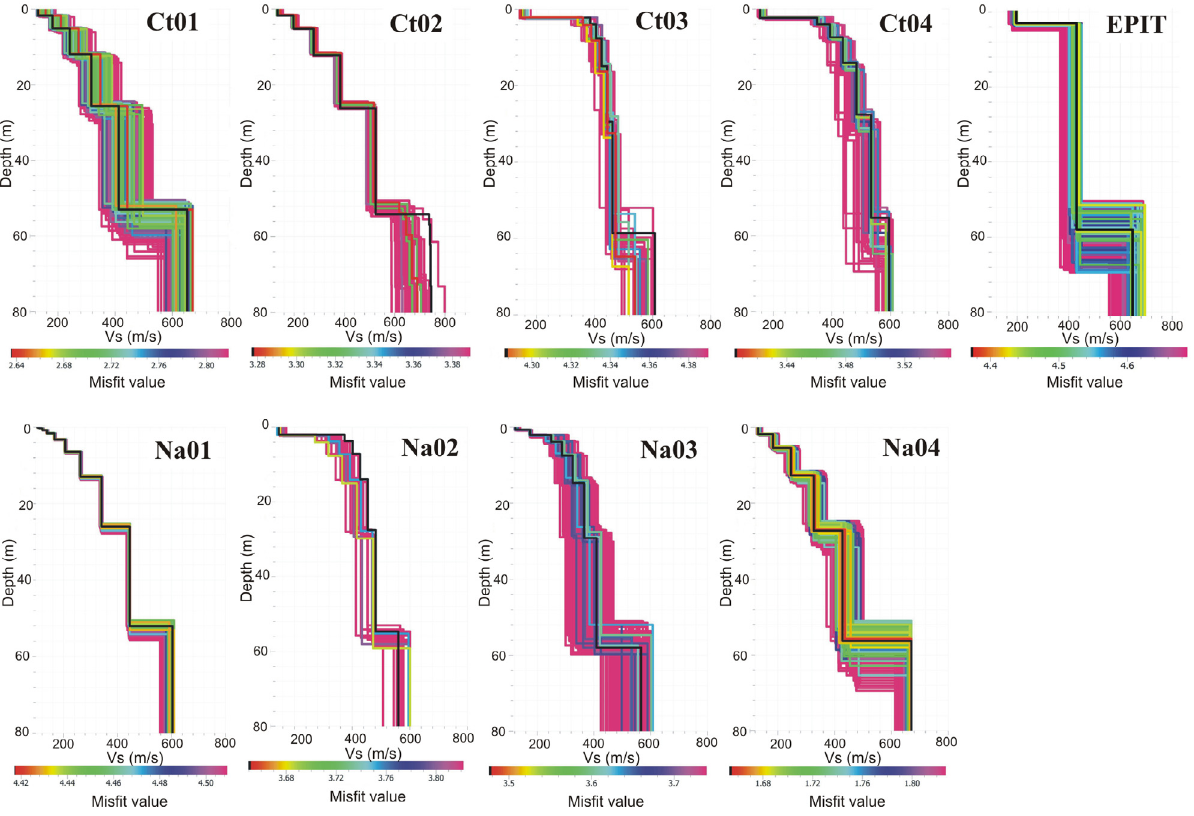
Figure 8. Shear wave 1D velocity profiles obtained by HVSR curves inversion. The black lines represent the velocity value corresponding to the minimum